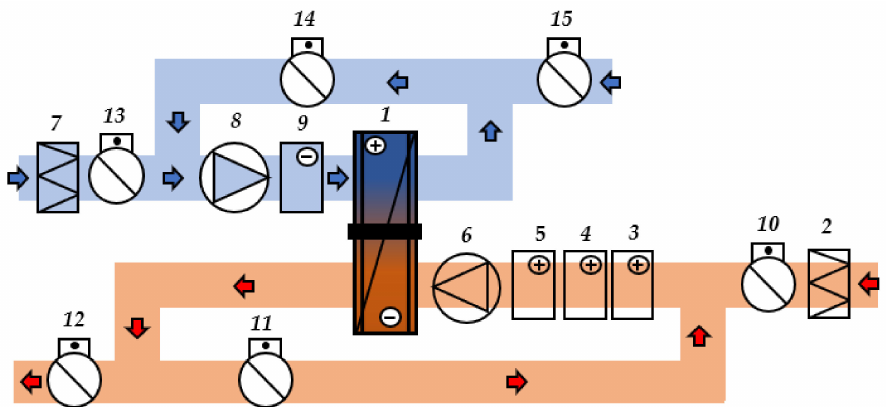
Figure 20. Diagram of the HPHE test rig: 1—HPHE; 2, 7—air filters; 3–5—electric preliminary heaters; 6, 8—air fans; 9—air cooler; 10–15—manual dampers.